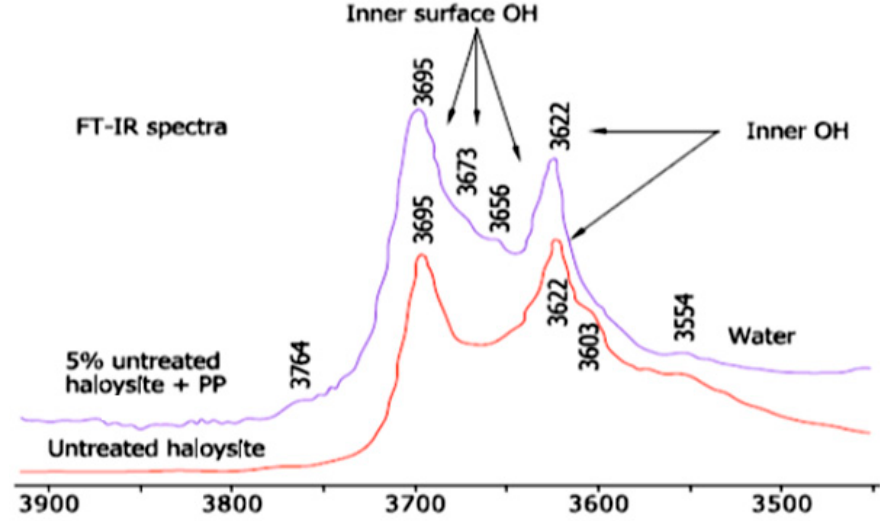
Figure 7. FTIR analysis of the halloysite [82].